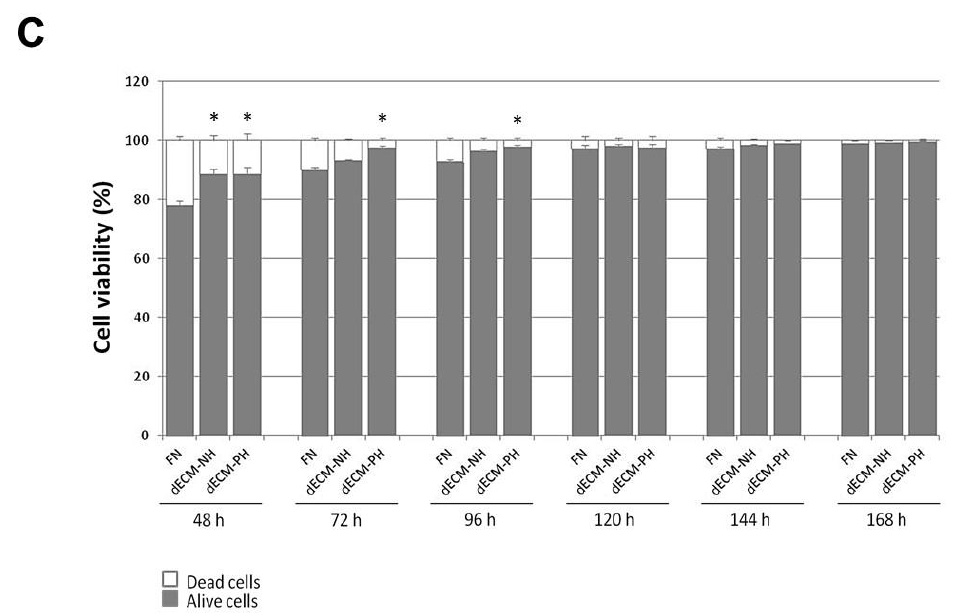
Figure 1. Experimental design, cell plating, and viability. ( A ) Schematic representation of the cell culture and seeding procedures on fibronectin coating (FN) and decellularized extracellular matrix (dECM) from normal hearts (NH) or pathological hearts (PH). ( B ) Representative merge live images (contrast phase + Hoescht fluorescence for nuclei) of human cardiac primitive stromal cells (hCPCs) 24 h after seeding on dECM-NH or dECM-PH. Scale bars = 20 µ m. ( C ) Cell viability time-course by Trypan Blue exclusion assay of CPCs seeded on FN, dECM-NH, or dECM-PH up to 1 week. *: p < 0.05 versus corresponding FN